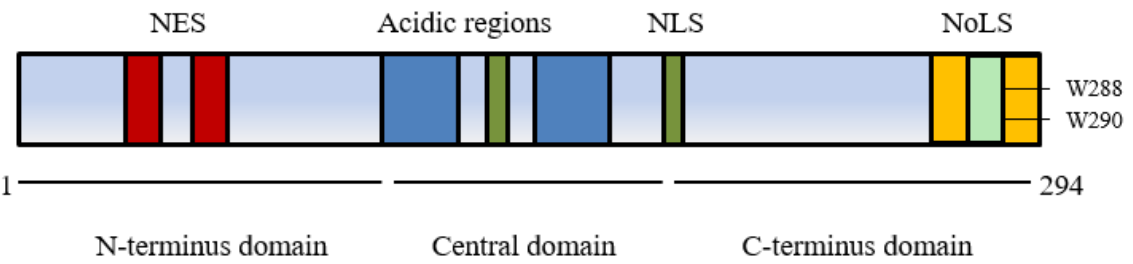
Figure 1. Nucleophosmin 1 protein structure showing the nuclear export signal (NES) in the N-terminus domain, the nuclear localisation signal (NLS) of the central domain and the nucleolar localisation signal (NoLS) in the C-terminus domain containing tryptophan at amino acid positions 288 and 290 [17].